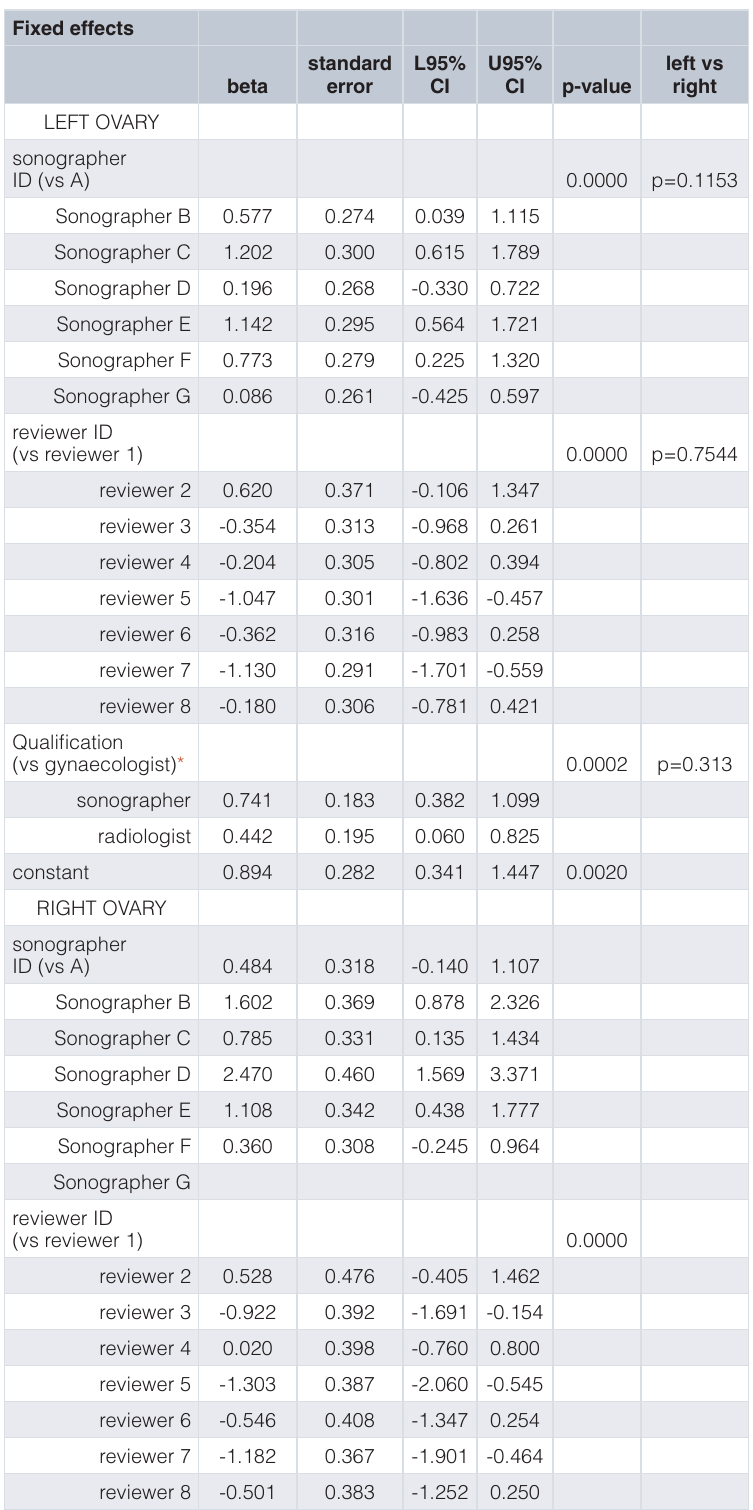
Table 1. Results of the random effects bivariate probit model – fixed and random effects. Fixed